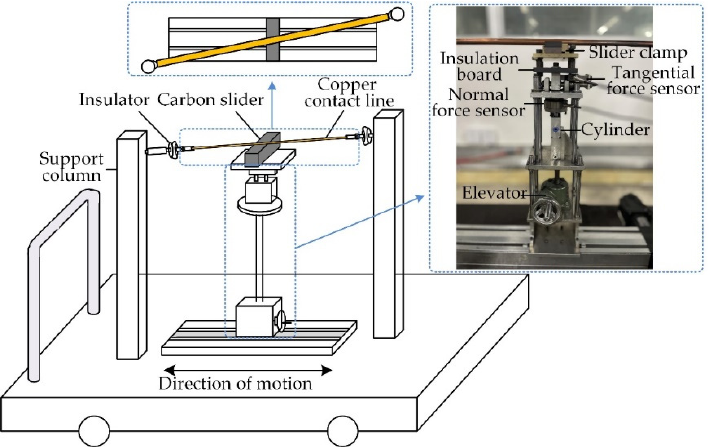
Figure 1. Schematic diagram of the reciprocating current-carrying friction and wear test facility.